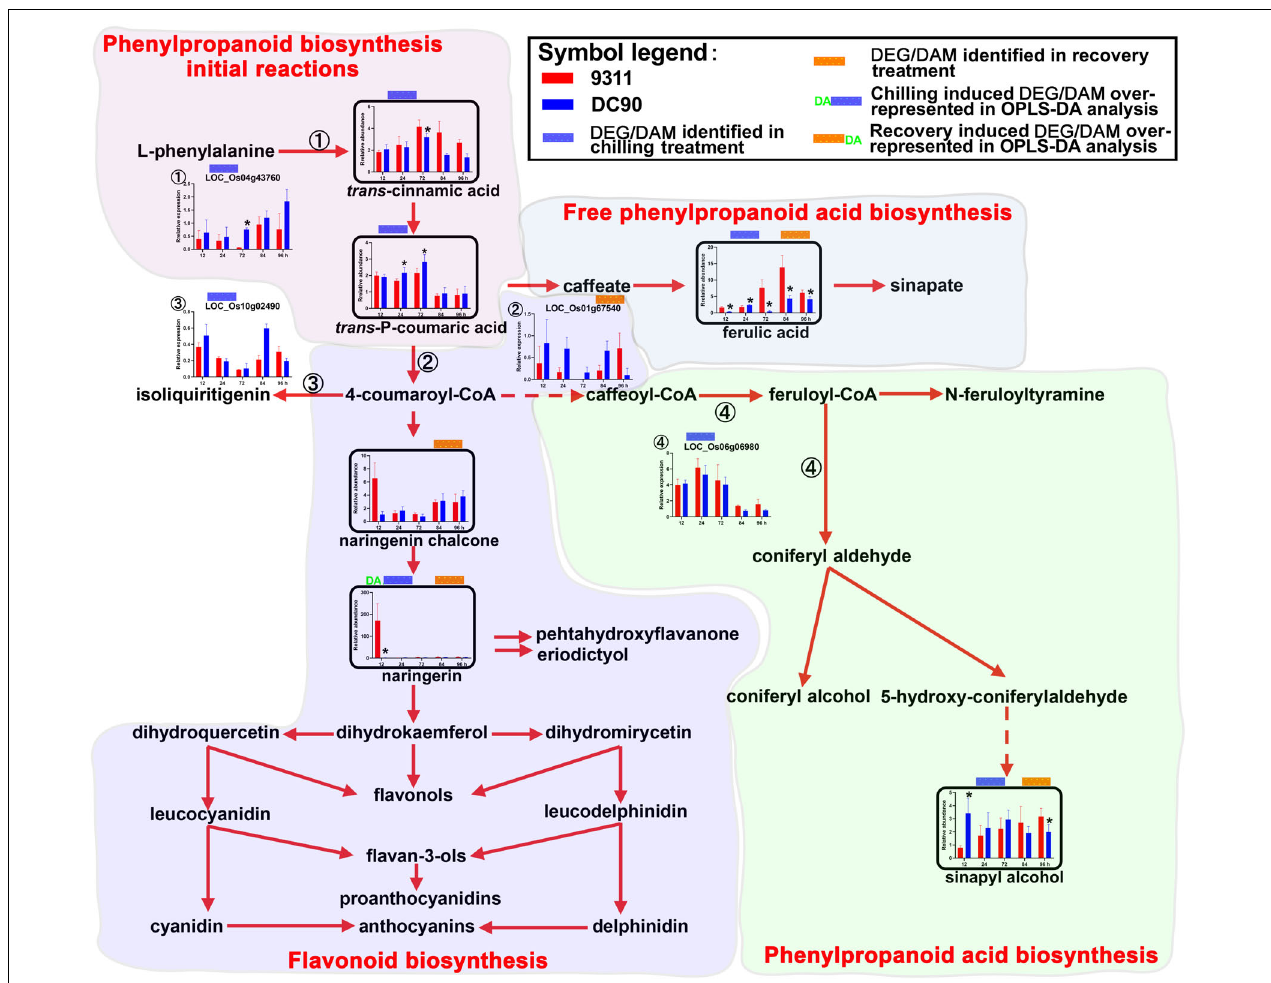
FIGURE 5 | Chilling- and/or recovery-induced DEGs and DAMs mapped to phenylpropanoid/flavonoids biosynthesis pathways. The boxed bar plots represent the metabolites with relative abundance alterations at certain timepoints in response to chilling (blue bar at the top) or recovery (orange bar at the top) treatment. The genes encoding related enzymes with relative expression level alteration plots are numbered accordingly. The blue and orange bars at the top of the plot represent the transcript or metabolite that was significantly altered in response to chilling (blue bar) and/or recovery (orange bar) treatment. The plot of transcripts or metabolites with the green letters DA to the left of the blue bar or to the right of the orange bar represent the transcript or metabolite members of discriminatory DEGs/DAMs that play key roles in differentiating the chilling tolerance capacity of 9311 and DC90. The red and dashed arrows represent overall upstream/downstream relationships and the conversion catalyzed by multiple steps in the related pathways, respectively. *Significant at P ≤ 0.05 level according to Student’s t